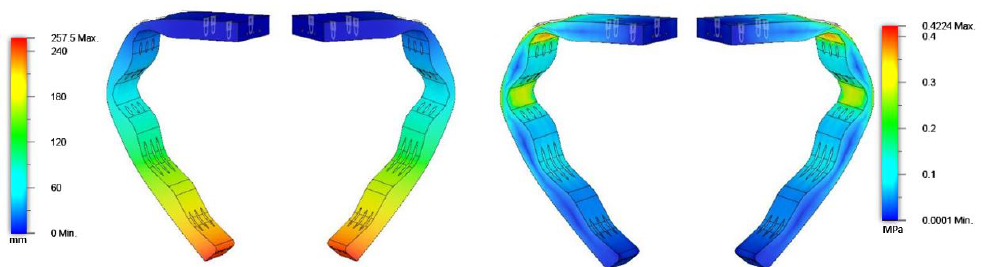
Figure 3. The left-hand image shows a study of the deformation for non-linear materials and the right-hand image shows a study of the